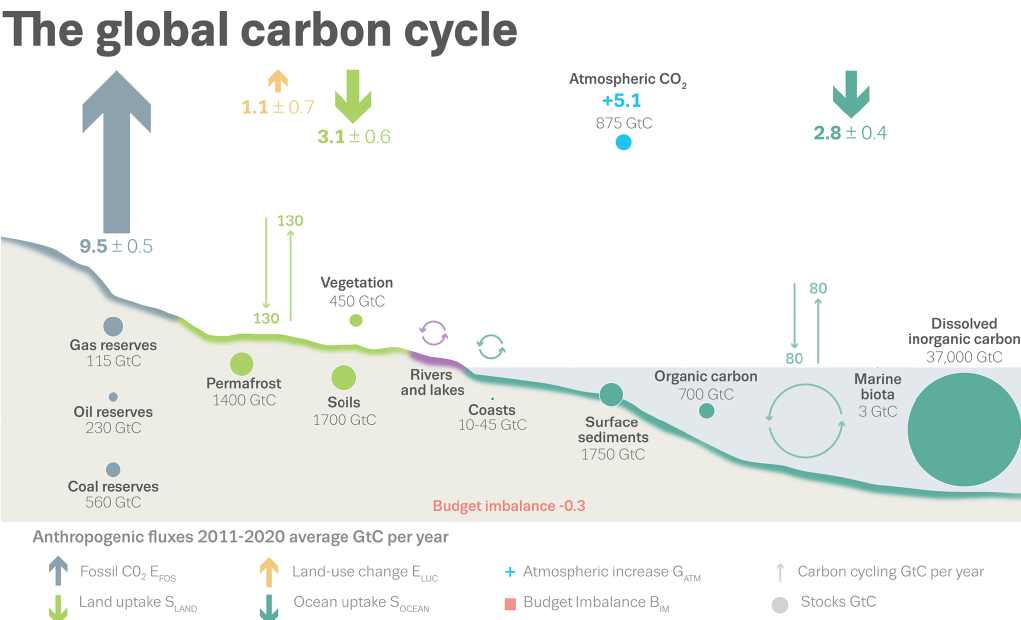
Figure 2. Schematic representation of the overall perturbation of the global carbon cycle caused by anthropogenic activities, averaged globally for the decade 2011–2020. See legends for the corresponding arrows and units. The uncertainty in the atmospheric CO 2 growth rate is very small ( ± 0.02GtCyr − 1 ) and is neglected for the figure. The anthropogenic perturbation occurs on top of an active carbon cycle, with fluxes and stocks represented in the background and taken from Canadell et al. (2022) for all numbers, except for the carbon stocks in coasts which is from a literature review of coastal marine sediments (Price and Warren, 2016). Table 1. Factors used to convert carbon in various units (by convention, Unit 1 = Unit 2 × conversion). Unit 1 Unit 2 GtC (gigatonnes of carbon) GtC (gigatonnes of carbon) GtCO 2 (gigatonnes of carbon dioxide) GtC (gigatonnes of carbon) GtC (gigatonnes of carbon) MtC (megatonnes of carbon) a Measurements of atmospheric CO 2 concentration have units of dry-air mole fraction; “ppm” is an abbreviation for micromole per mole of dry air. a factor of 2.124 assumes that all the atmosphere is well mixed within 1 year. In reality, only the troposphere is well mixed, and the growth rate of CO 2 concentration in the less well-mixed stratosphere is not measured by sites from the NOAA network. Using a factor of 2.124 makes the approximation that the growth rate of CO 2 concentration in the stratosphere is equal to that of the troposphere on a yearly